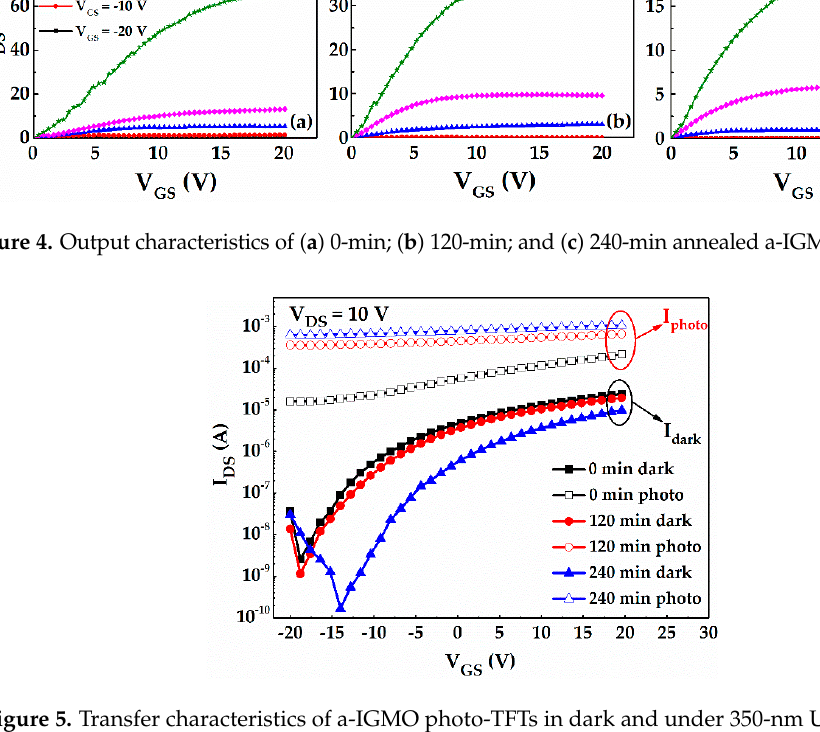
Figure 5. Transfer characteristics of a-IGMO photo-TFTs in dark and under 350-nm UV radiation.